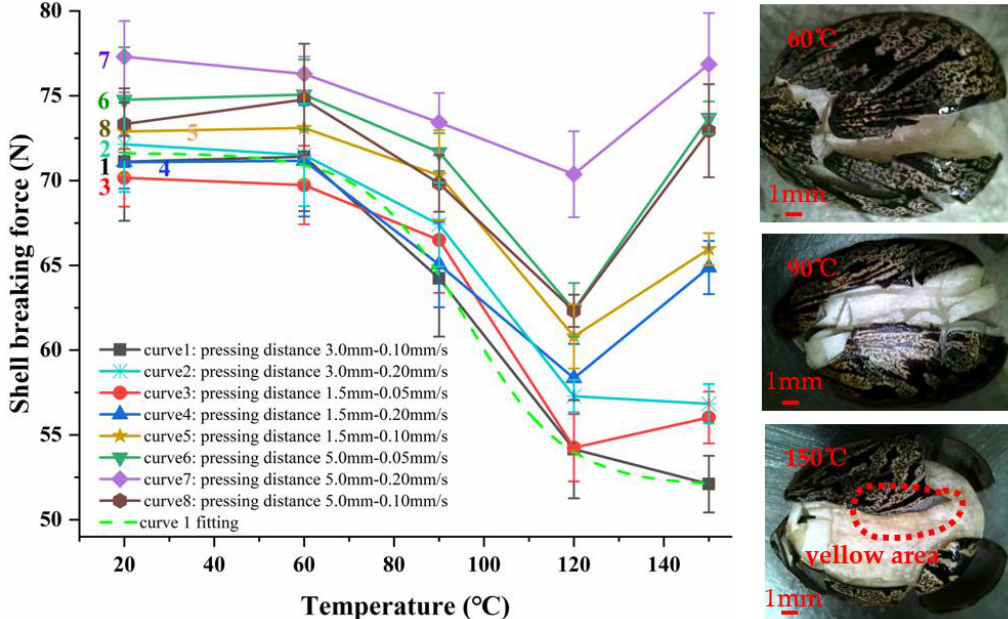
Figure 6. Temperature-shell breaking force curve and corresponding observation image for curve 1 under different tem- peratures.